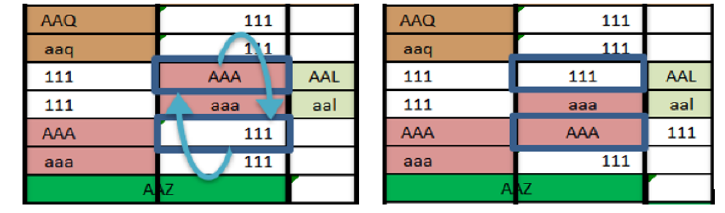
Figure 5. Two solutions of the same